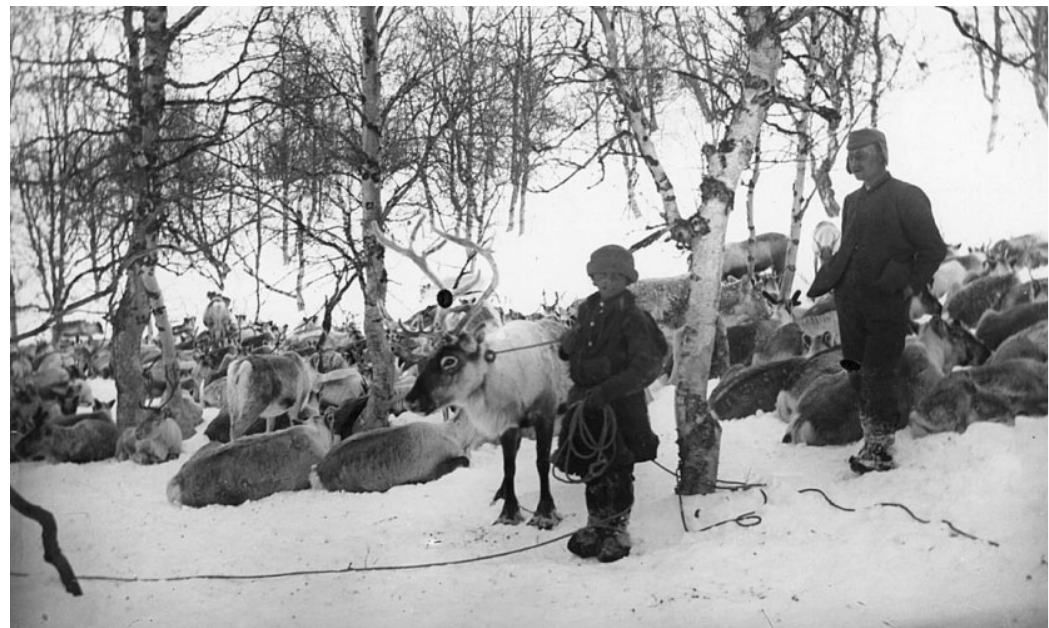
Fig. 4. Reindeer herd in Tjalanes, near Sulitjelma, Nordland County, 1906. After it had become illegal to move custo- dial reindeer across the boarder, people from Saltdal bought up a small herd in the autumn, which they them- selves butchered some distance away from the settled area. Photo: From Evjen,